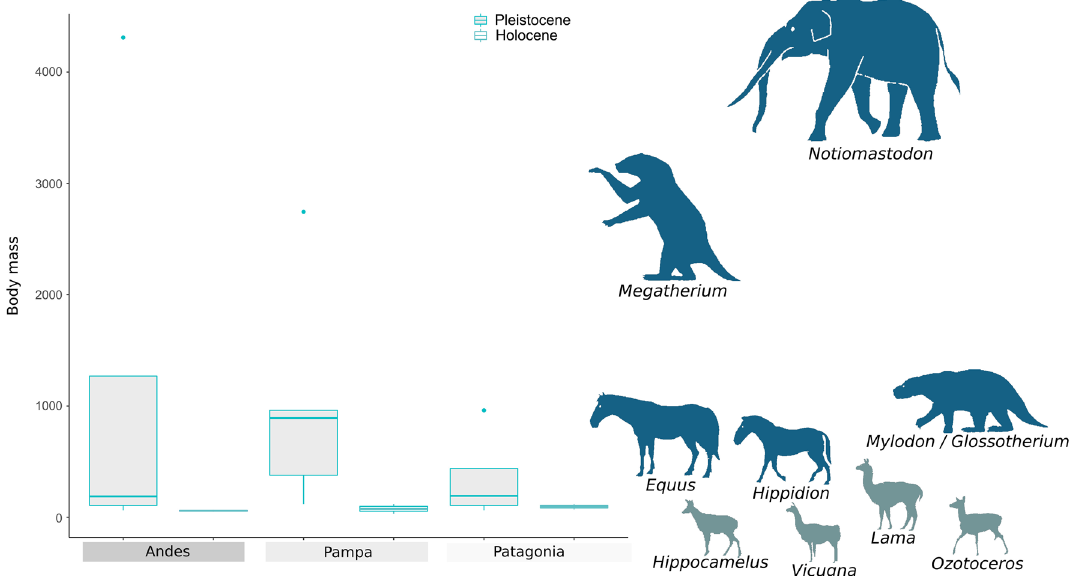
Figure 4. Body size variation in megafaunal species hunted by humans. Box-plots of body mass (in kg) of megafauna by region and period. The graph shows the minimum and maximum values (whiskers), the first and third quartiles (bounds of box), and the median (center